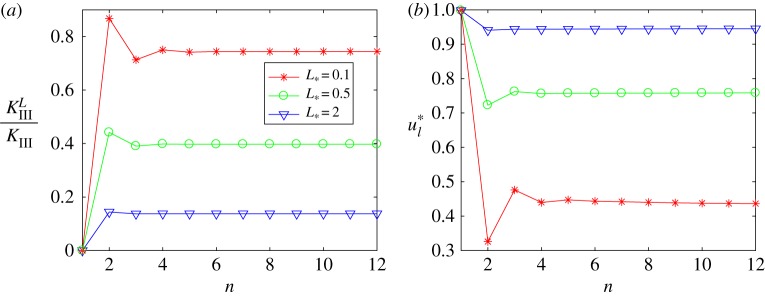
Convergence of the values of LEFM parameters with the iterations. (Online version in colour.)